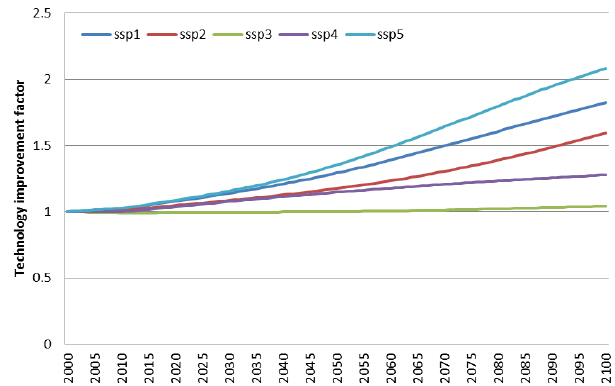
Figure B5. Development of mean technology improvement factor for all countries for the socio-economic pathways.